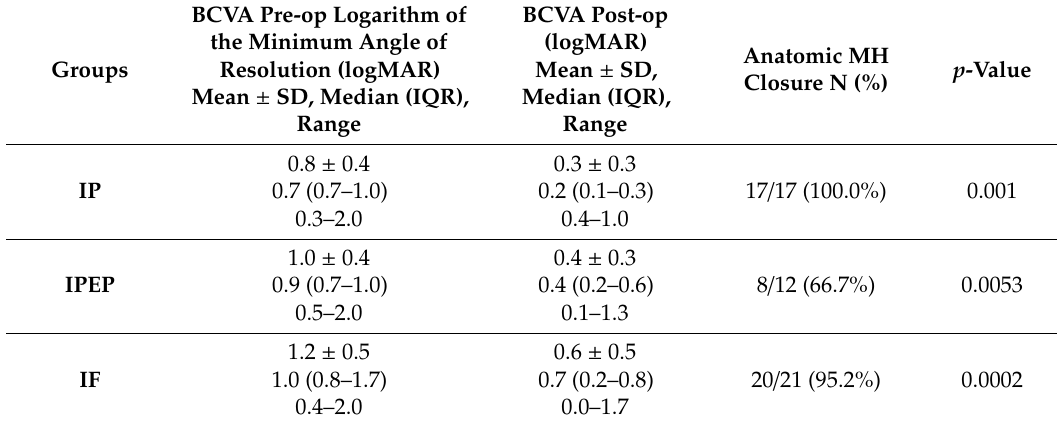
Table 3. Functional and anatomical results with comparison of the visual acuity before and after